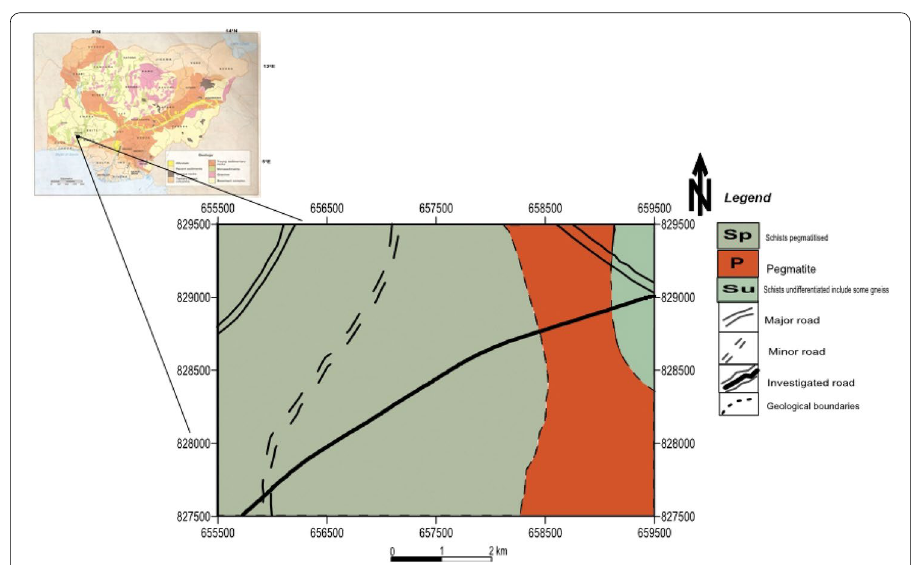
Fig. 2 Geology map of Nigeria (After [5] and Geology of the Study Area (Adapted from